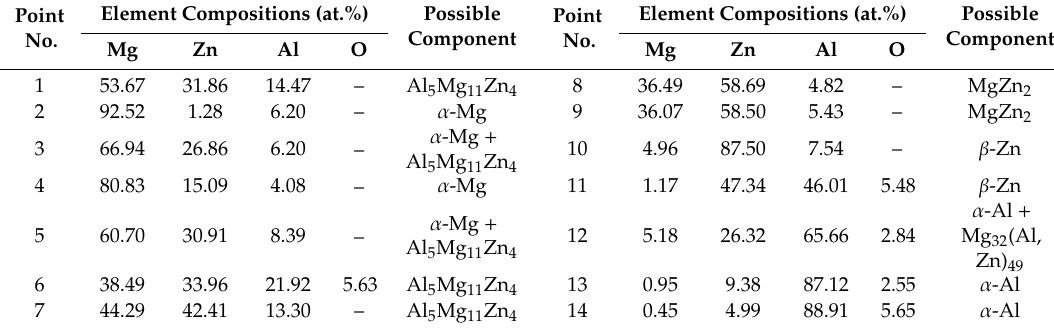
Figure 5. SEM micrographs of the interface in arc-sprayed Al / AZ91D with a Zn interlayer (arc-spraying Zn for 18 s and Al / Zn double-deck coating preheated for 6 h): ( a ) general view, ( b – e ) areas A, B, C, and D in ( a ), respectively. Table 4. EDS analysis results corresponding to the points marked in Figure